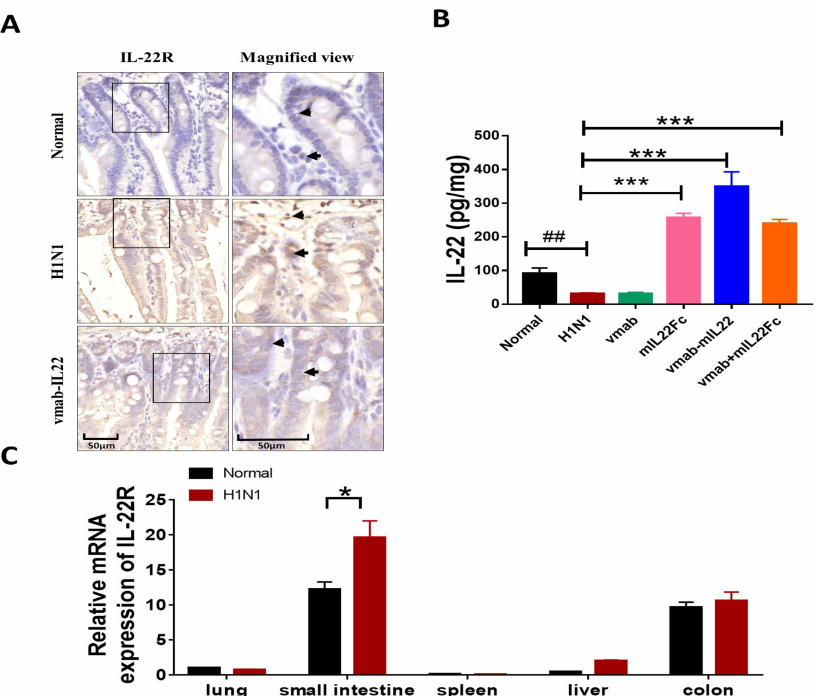
Figure 3. Vmab-mIL22 treatment increases the expression of IL22R in influenza A virus-infected mice. The infection and treatment schemes were the same as in Figure 1. ( A ) The expression of IL22R protein in small intestine was measured using IHC in H1N1-infected mice ( n = 4); positive cells are indicated by triangles and arrows. ( B ) The expression of IL22 in the small intestine homogenate was assayed using ELISA following treatment with vmab-mIL22 ( n = 6). ( C ) The distribution and transcription levels of IL22R was determined in the lung, small intestine, colon, liver and spleen using RT-PCR in H1N1-infected mice ( n = 4).## p < 0.01 for comparison of mice in H1N1 group to the normal group, * p < 0.05, *** p < 0.001 for comparison of mice in treated group to the H1N1